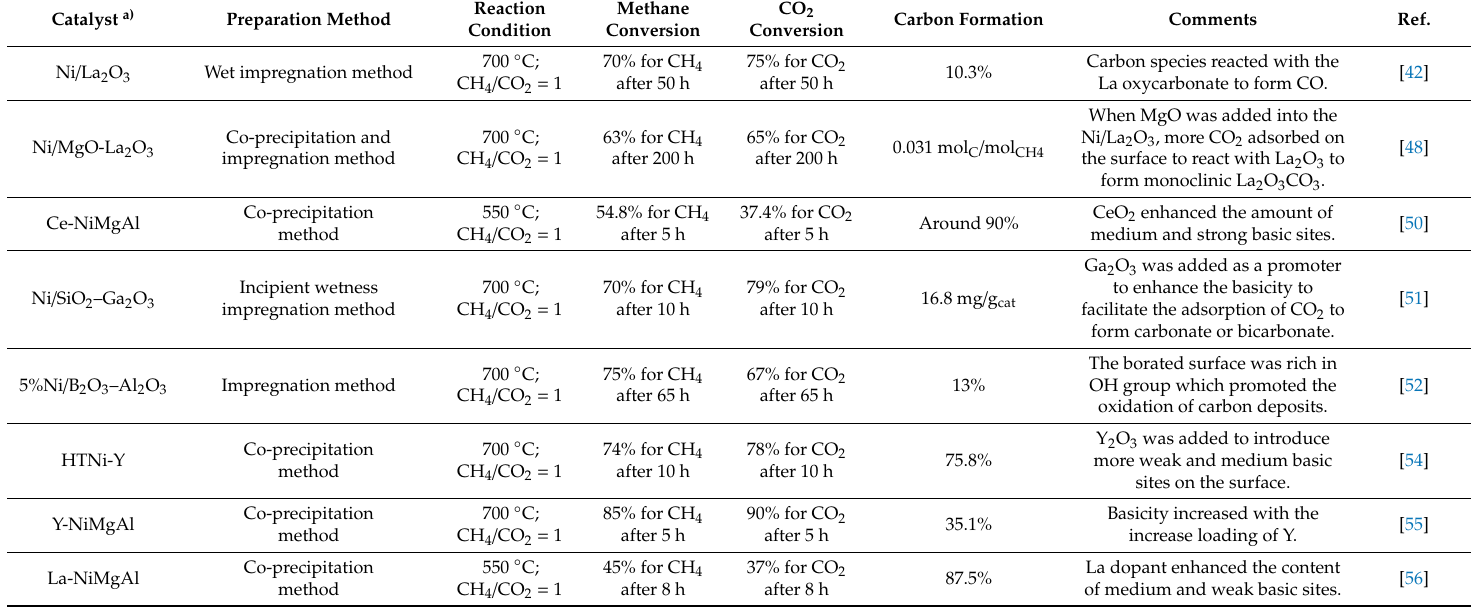
Table 1. A summary of surface regulation e ff ects on the catalytic performances of Ni-based catalysts for DRM